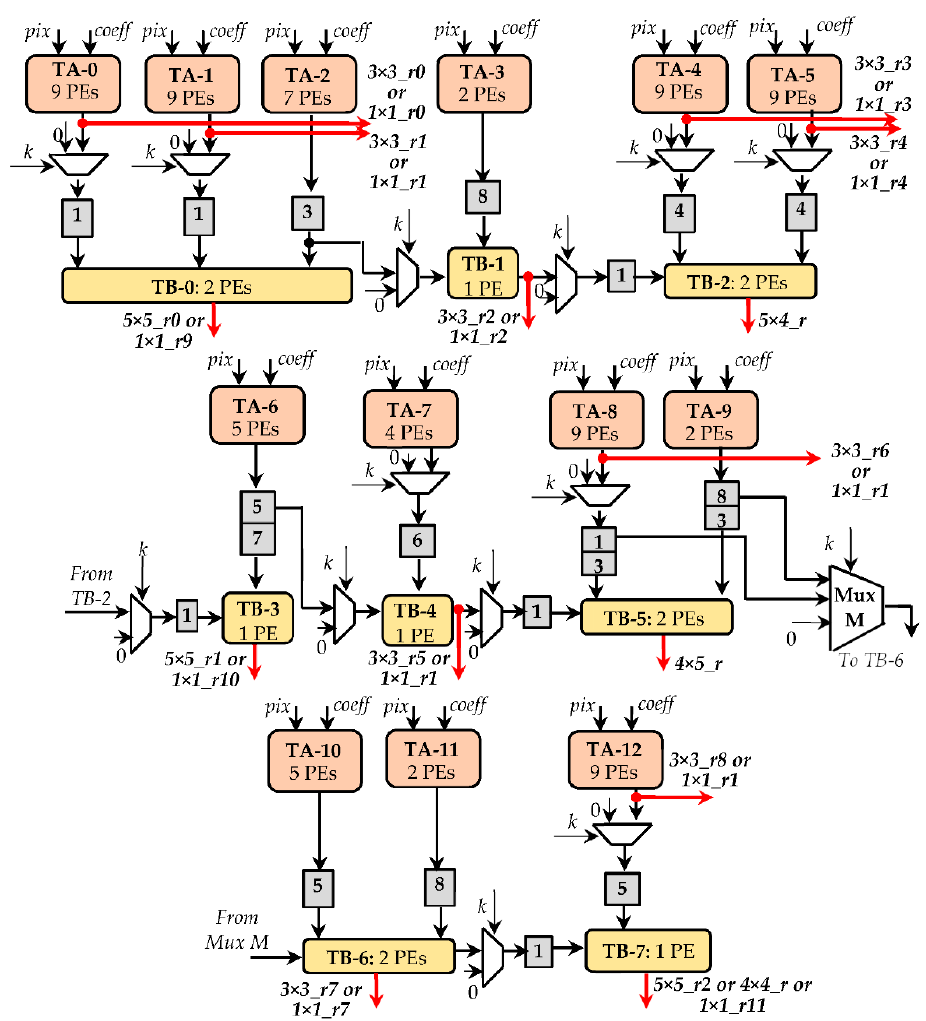
Figure 8. Example of PEs arranged in tiles: ( a ) TA with four Pes; ( b ) TB with two PEs.